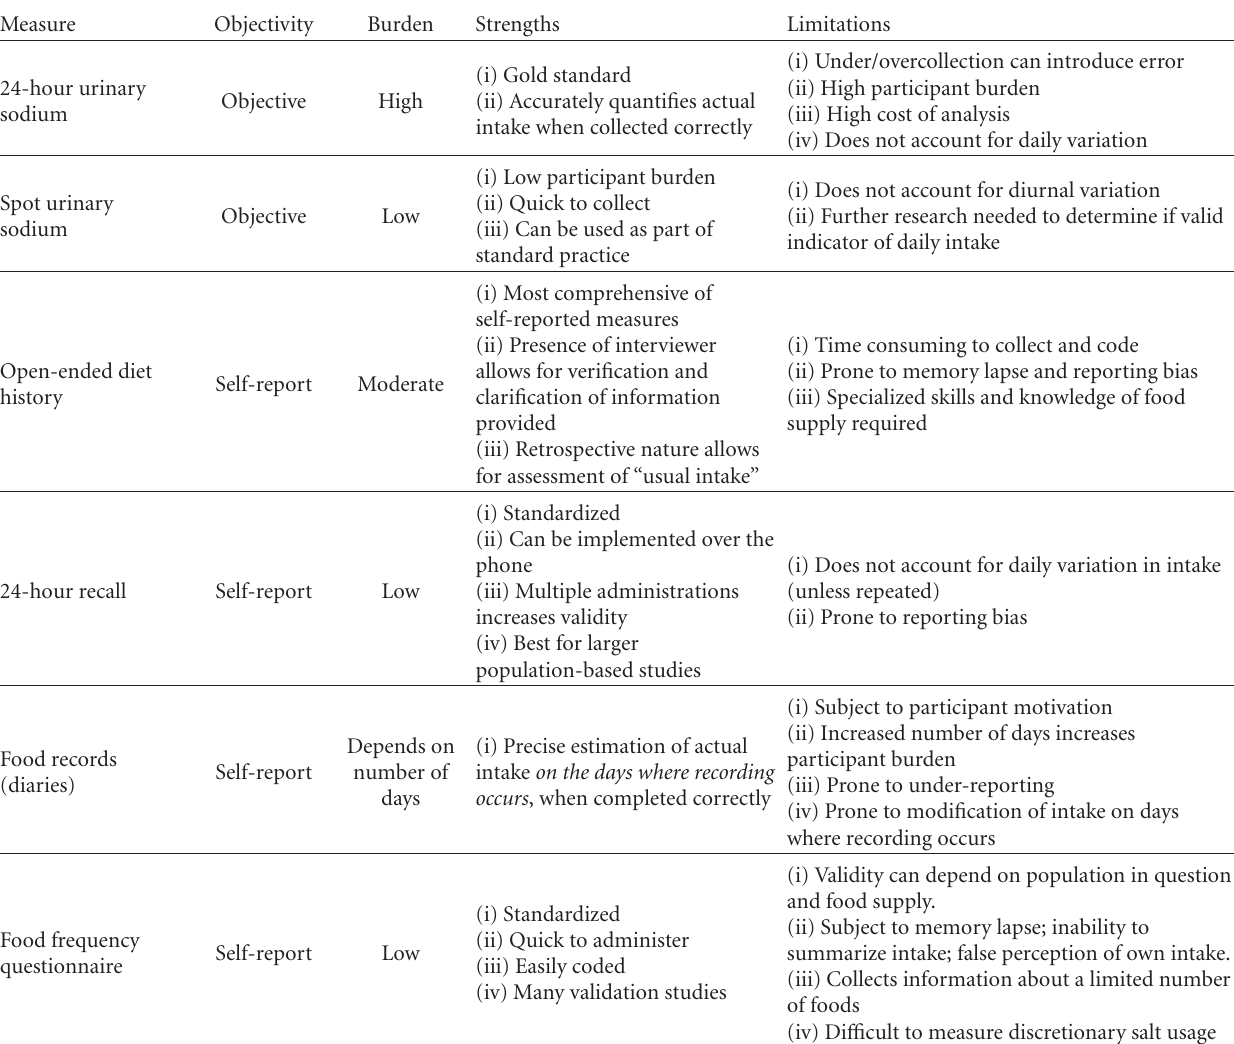
Table 1: Summary of measures that can be used to estimate sodium